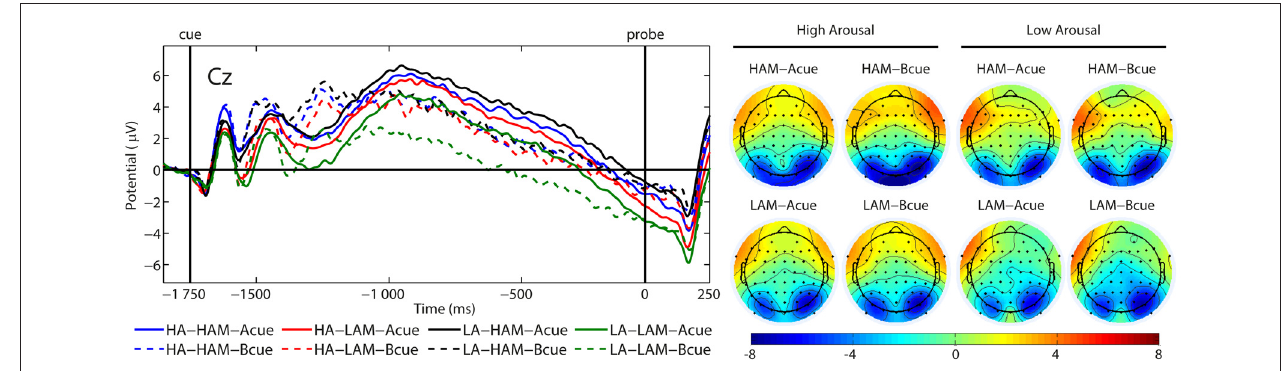
FIGURE 6 | Grand average (ERPs) contingent negative variation (CNV) and topographical maps elicited by the A cue (solid lines) and the B cue (dashed lines) at Cz, separately for low (LA) and high (HA) arousal and low (LAM) and high (HAM) motivated positive affect.